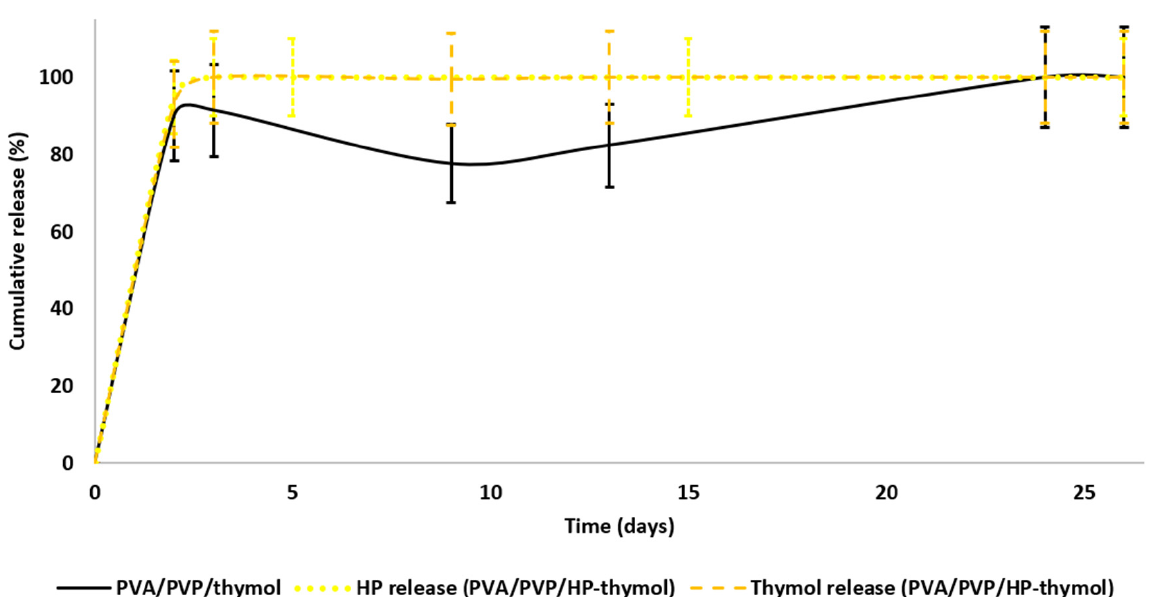
Figure 5. Cumulative release of HP (yellow-dotted line) and thymol (orange-dashed line) from PVA/PVP/HP-thymol (0.63 w% each of HP and thymol) and of thymol (black line) from PVA/PVP/thymol (1.25 w% thymol) to the hay environment (performed in triplicate).